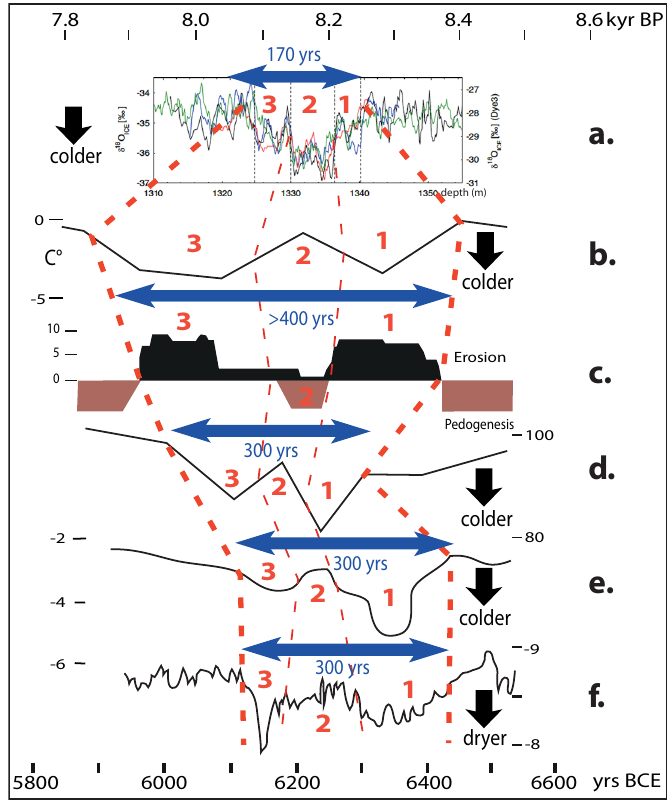
Figure 5: ( a ) Oxygene isotops ratios for GRIP, GISP2, NGRIP, and DYE 3 cores with 20 years running average, illustrating the drop in temperature in the high latitudes of the northern hemisphere around Greenland over 170 years ( Thomas et al., 2007 ) . ( b ) Pollen - based temperature of the coldest month in Lake Maliq ( Albania ) , from a transfer function of pollen assemblages using the modern analogue technique ( Bordon, Peyron, Lézine, Brewer, & Fouache, 2009 ) . ( c ) Results of SPD analysis of Sidari 1 – 2 sequences ( Corfu Island, Greece ) identifying two marked phases of erosion ( black curve ) , separated by a short phase of pedogenesis ( brown curve ) , during a four century phase associated with the 8.2 ka event ( Berger et al., 2016 ) . ( d ) SL21 E - Tripartite oscillation of the Aegean Sea Surface temperatures, close to the island of Crete by variations of the percentage of warm foraminifera species ( Rohling et al., 2002 ) . ( e ) Tripartite variations in temperature restituted by the isotopic records of an Irish speleothem in Crag cave ( Ireland ) ( ‰ VPDP ) ( McDermott, Mattey, & Hawkesworth, 2001 ) . ( f ) Tripartite variations of the Asian monsoon activity restituted by the isotopic records of Dongge cave, China ( Dykoski et al., 2005 ) . A common tripartite pattern ( phases 1 – 3 ) emerges from this confrontation of several palaeoenvironmental archives, distributed between the tropical and polar zones, which testi fi es to the same tempo on a hemispheric